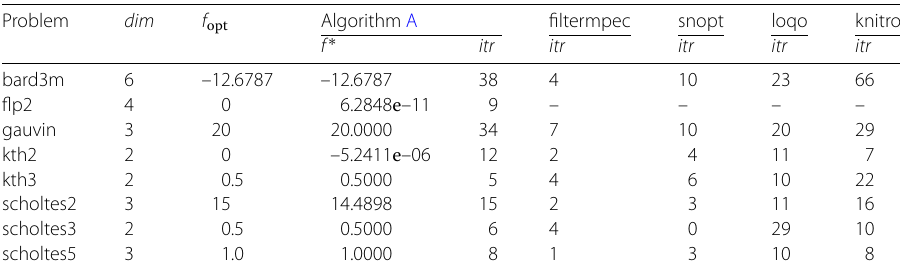
Table 1 The computational results